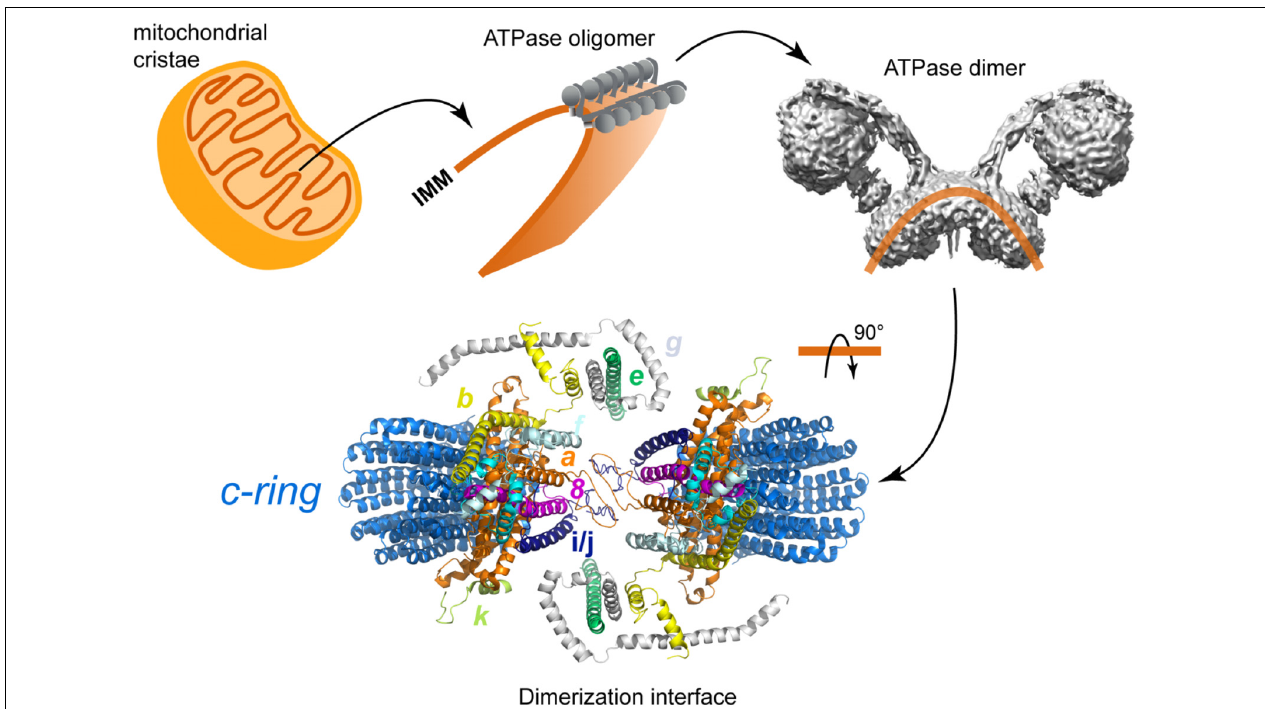
FIGURE 9 | Schematic representation of the dimerization of the yeast F-ATPase. Model of the F O section in which all the subunits involved in the dimerization are colored: subunit a in hot pink, subunit b in cyan, subunit e in brown, subunit g in pale blue, subunit j in dark blue, and subunit k in lemon. The dimerization interface includes the subunits proposed by Habersetzer et al. (2013) and Guo et al. (2017). The model corresponds to the structural data deposited with the PDB 6B2Z (Guo et al.,